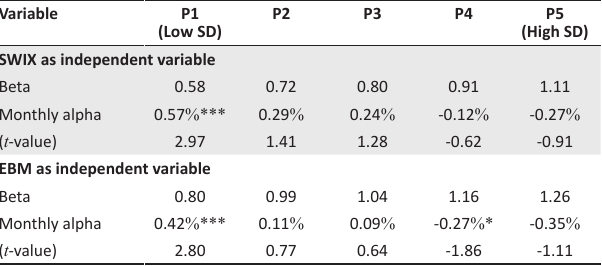
TABLE 4: Standard deviation sorted quintile portfolio capital asset pricing model style